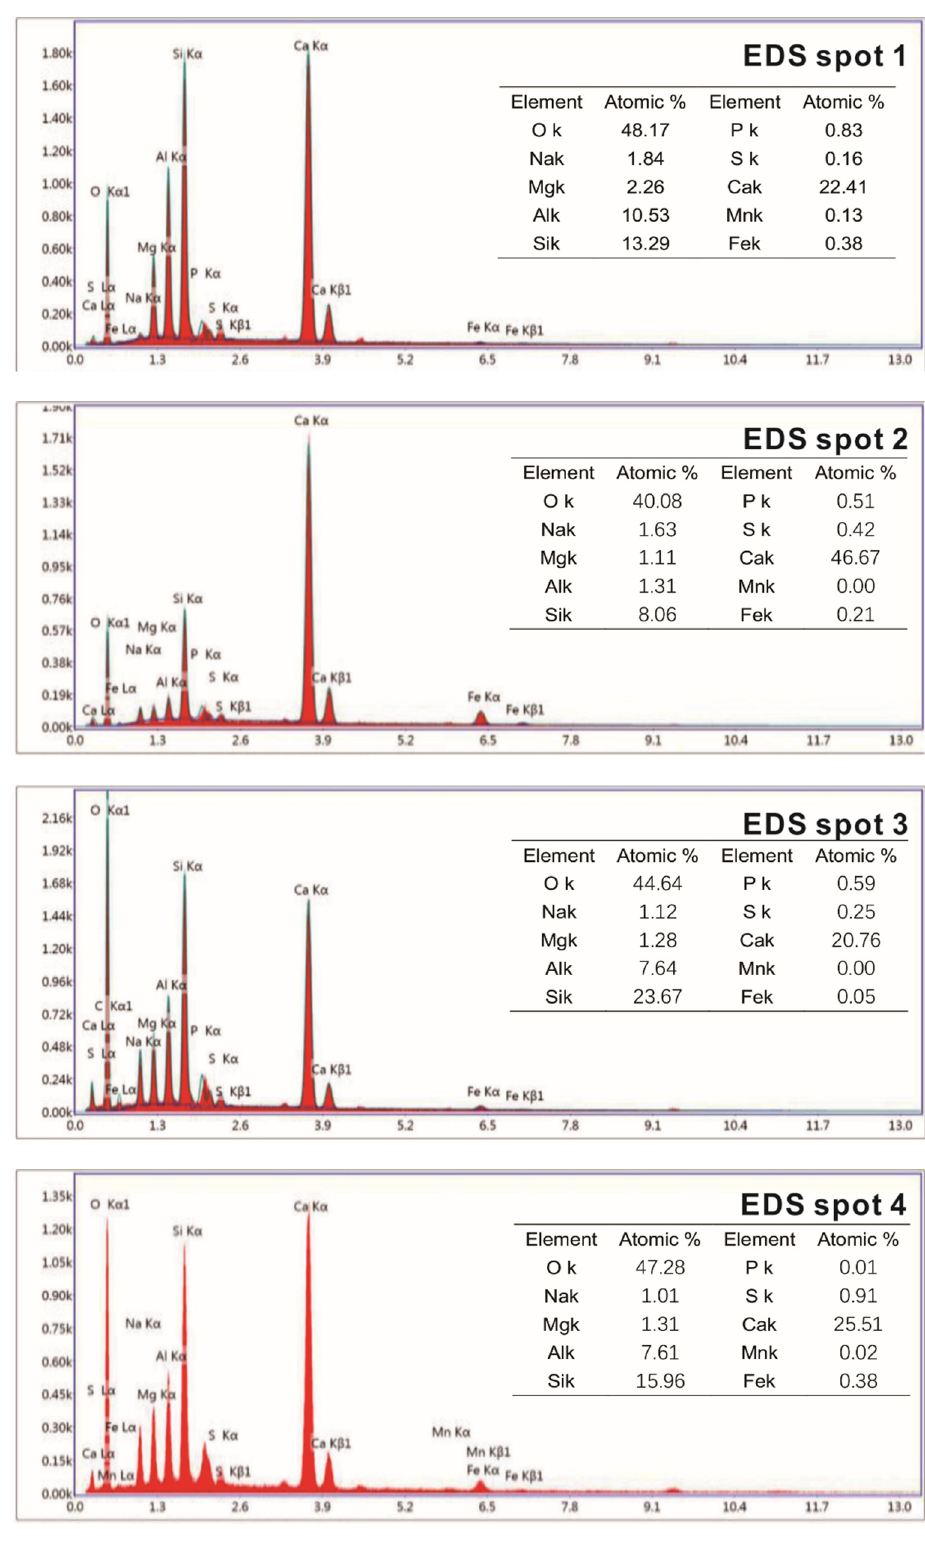
Figure 9. SEM-EDS images of 1 day of curing samples. ( a ) SEM images of 1 day of curing samples, ( b ) EDS images of local region. (2) 3 days of curing